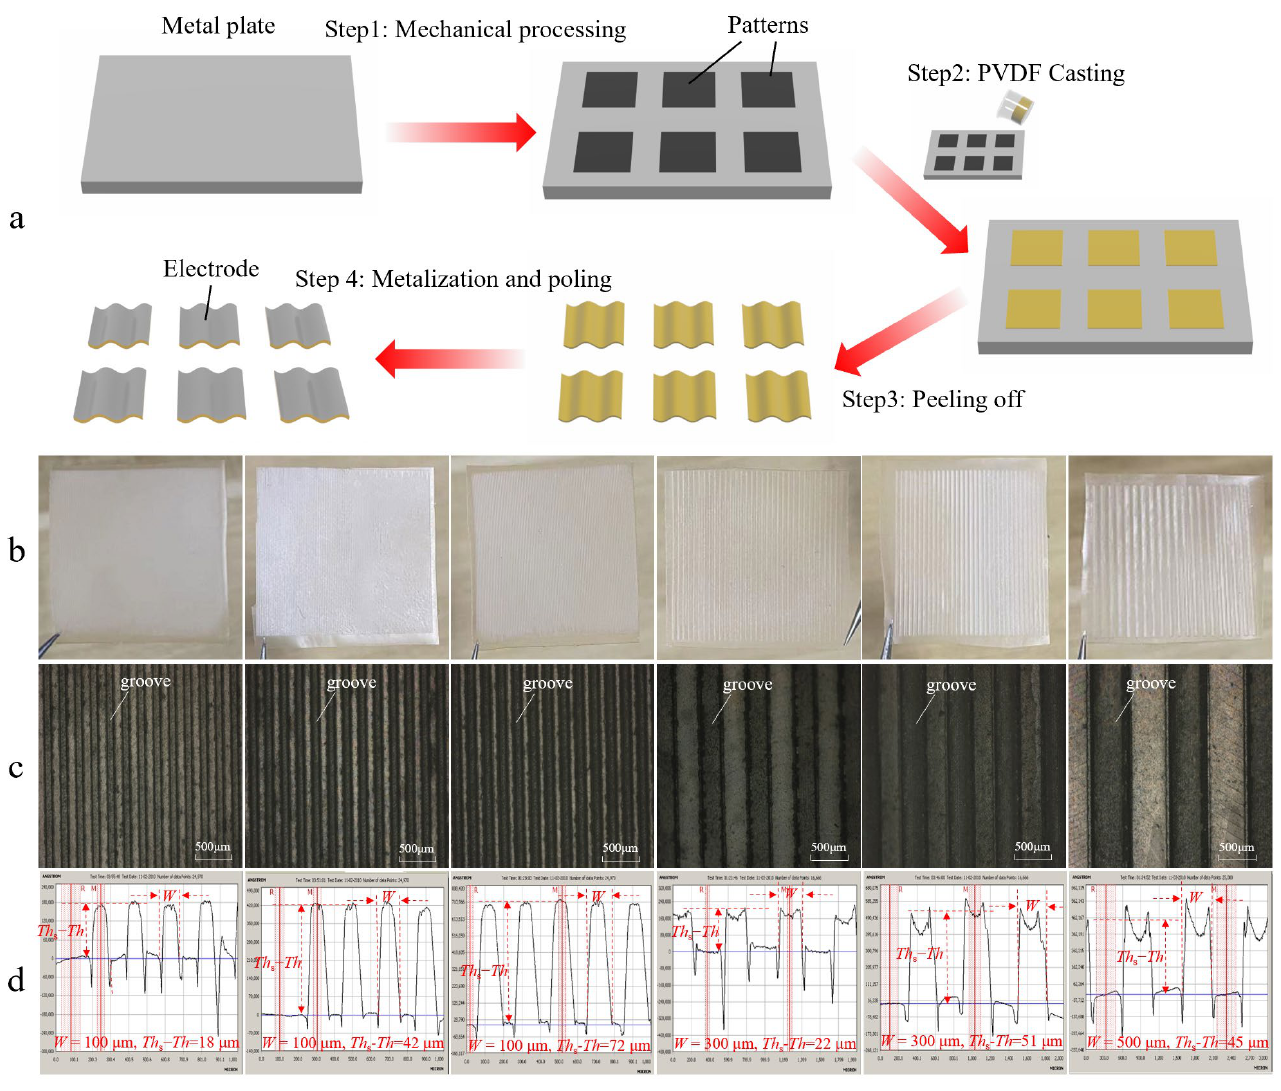
Figure 4. ( a ) Steps for microstructured PVDF films fabrication process; ( b ) photos of microstructured PVDF film samples (with the designed parameters given in the photos); ( c ) photos of morphologies of PVDF film samples; ( d ) measurement results of profiles of PVDF film samples (with the measured parameters given in the photos). Table 2. Measured parameters (the meaning of W , Th and Th s can be referred to Figure 1, R e —nor- malized experimental response results, F β —β phase content) and normalized simulation response results ( R s ) of samples.